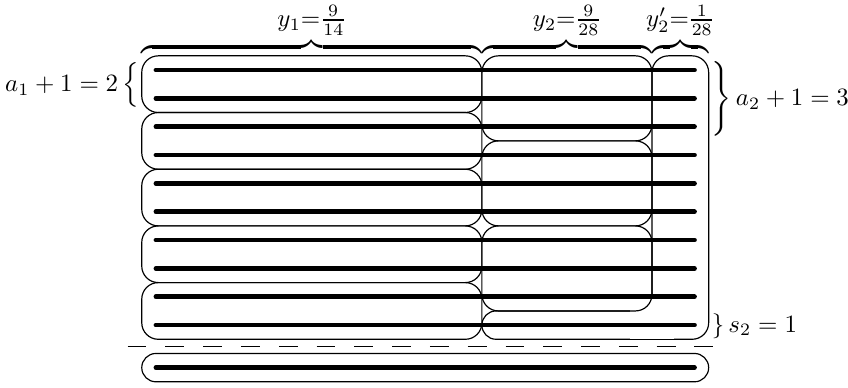
Figure 7: Graphical representation of a normalised ∆( ˜ d, 10) 11 –partite colouring with a nor- malised colour class induced maximum degree of α (10 , 11) = 9 / 14